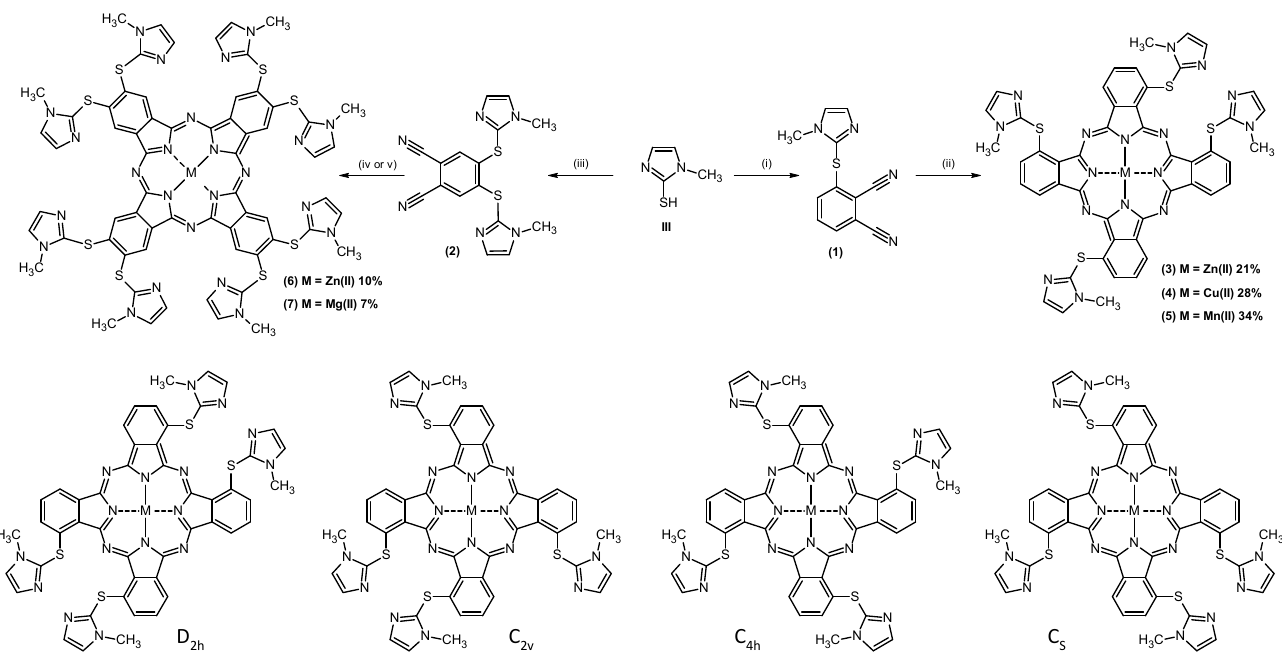
Scheme 1. Synthesis of new compounds 1 – 7 . Reagents ( 1 , 2 , III ) and conditions and yields: ( i ) 3-nitrophthalonitrile, anhydrous K 2 CO 3 , DMF, 80 °C, 24 h, 79%; ( ii ) appropriate salt (Zn(OAc) 2 for Zn, CuCl 2 for Cu and MnCl 2 ∙ 4 H 2 O for Mn), DBU, n- pentanol, 140 °C, 24 h; ( iii ) 4,5-dichlorophthalonitrile, anhydrous K 2 CO 3 , DMF, 80 °C, 24 h, 81%. ( iv ) Zn(OAc) 2 , DBU, n -pentanol, 140 °C, 24 h; ( v ) Mg, n -butanol, cat. I 2 , reflux 3 h, then, 2 , reflux, 24 h. The possible structural isomers of compounds 3 – 5 with symmetrical D 2h , C 4h , C 2v and C s . Structures of octasub- stituted phthalocyanines 6 and 7 .